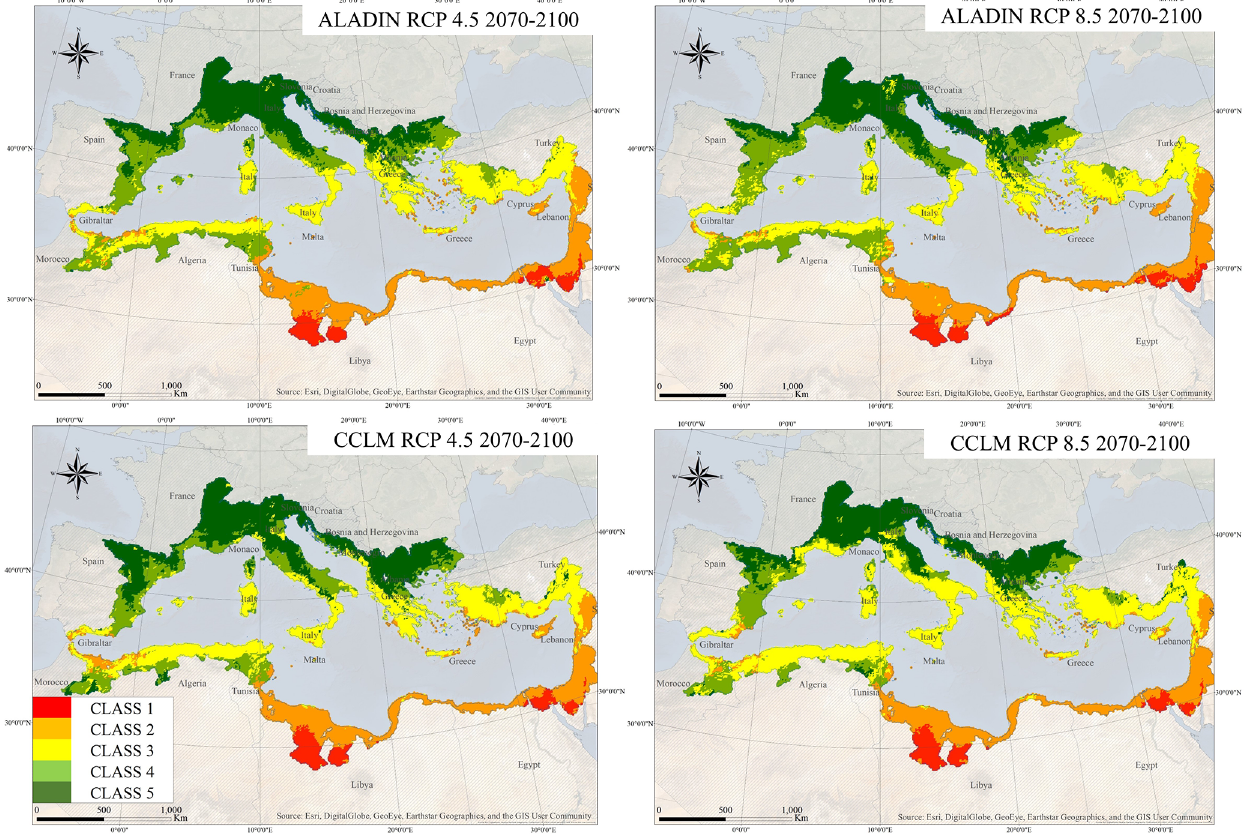
Figure 7. Projected geographical distribution of the Mediterranean climatic classes based on WorldClim-2 gridded climatic indices using projected data under the ALADIN and CCLM RCP4.5 and 8.5 scenarios for the 2070–2100